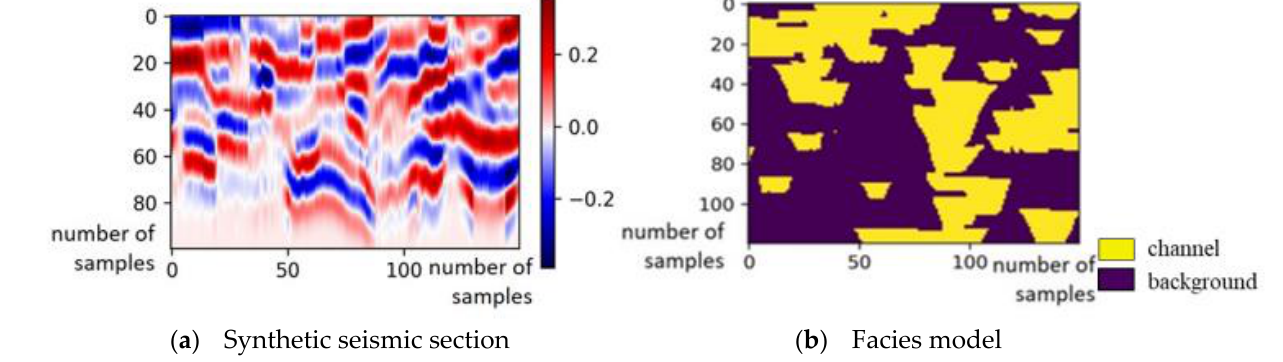
Figure 1. Synthetic seismic section ( a ) and corresponding facies ( b ). Note that axes show the number of samples, not physical parameters.